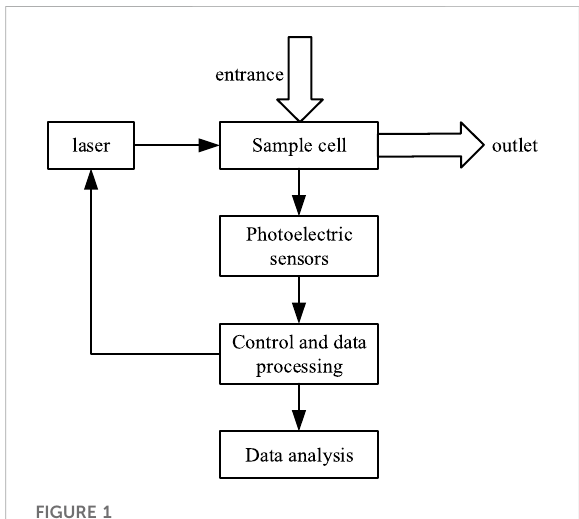
FIGURE 1 Schematic diagram of particle optical experimental